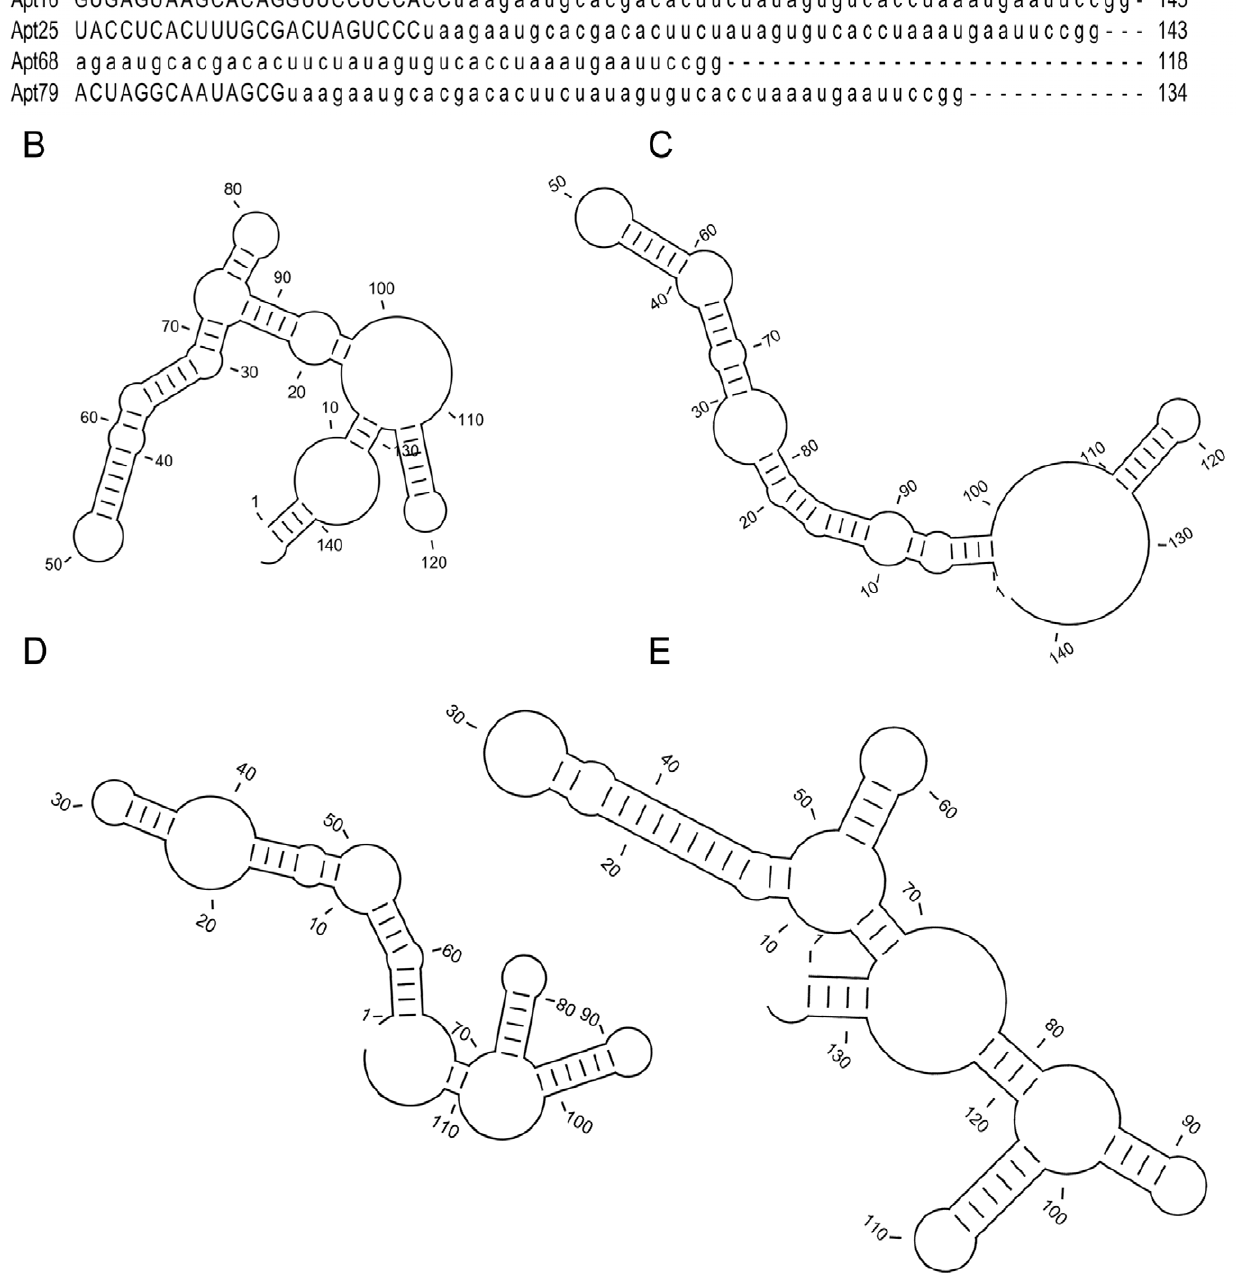
Figure 1. T.cruzi whole cell binding aptamer sequences. Nucleotide sequence including the conserved T7 and SP6 primer binding sites, depicted in lower case letters, of the four selected RNA aptamers, Apt16, Apt25, Apt68 and Apt79, obtained from the T. cruzi trypomastigote whole- cell SELEX is represented (A). The length of each aptamer sequence is indicated on the right. Predicted secondary structure obtained from Minimal Free Energy (MFE) calculations of Apt16, 25, 68 and 79 are shown in panels B, C, D and E, respectively.